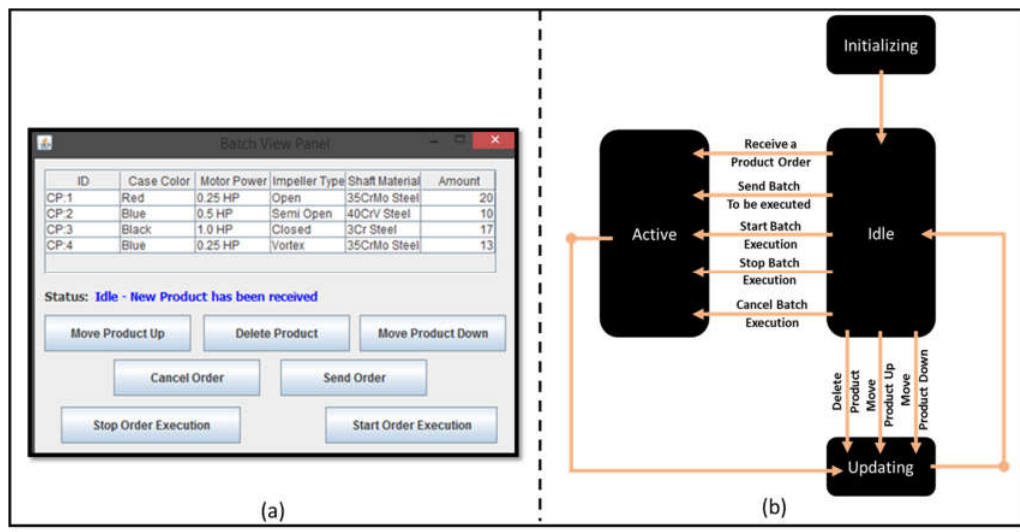
Figure 6. ( a ) TH (Task Holon) User Interface; ( b ) TH State-Machine.